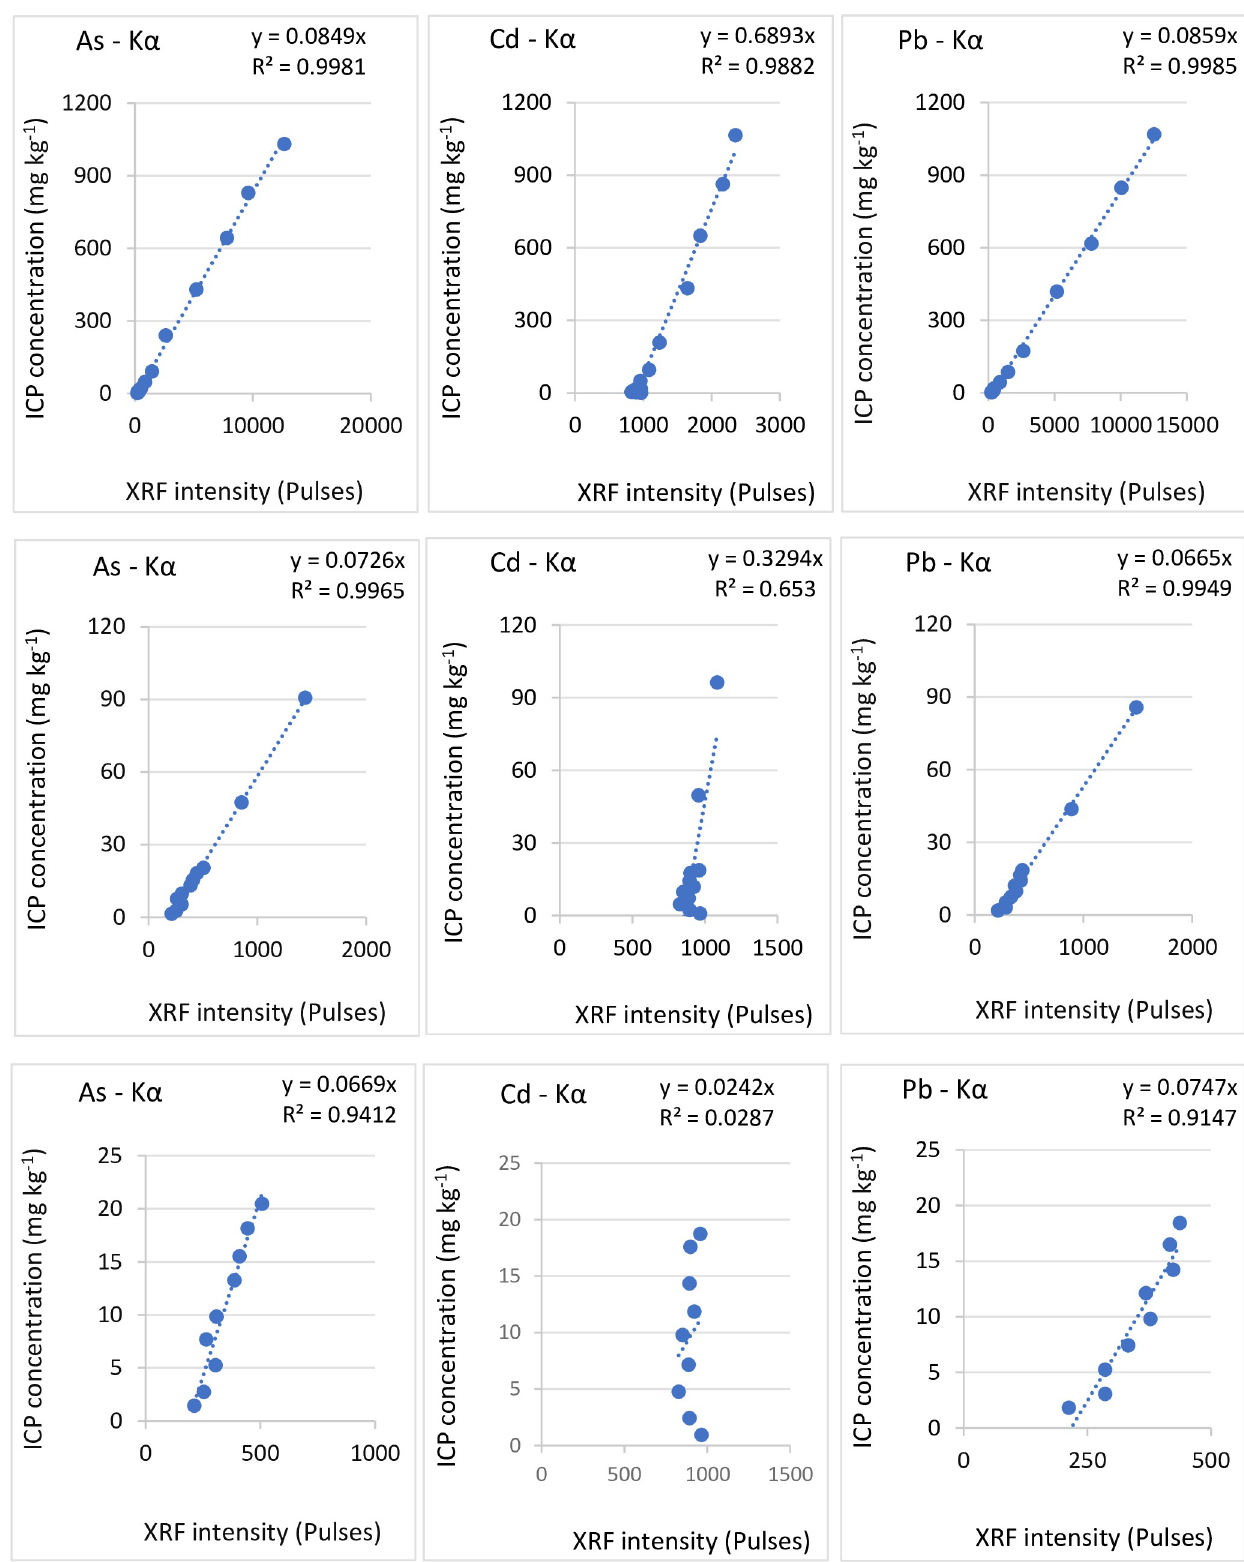
Fig 3. Correlation between XRF intensity and ICP concentration. As, Cd and Pb in SOP for three different concentration ranges; 0–1000 mg kg -1 in the top row, 0–100 mg kg -1 in the middle row and 0–20 mg kg -1 in the bottom row. https://doi.org/10.1371/journal.pone.0262460.g003 PLOS ONE | https://doi.org/10.1371/journal.pone.0262460 January 11,